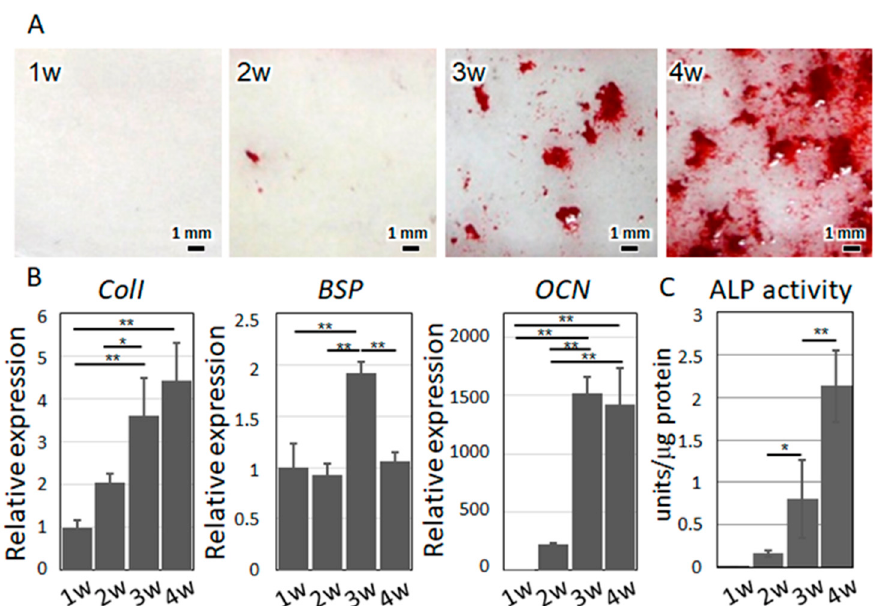
Figure 3. ( A ) Mineralized nodules were visualized by alizarin red S staining. ( B ) Gene expression analysis of osteoblast marker molecules. ColI , collagen I; BSP , bone sialoprotein; OCN , osteocalcin. ( C ) ALP activity depending on the cultivation period is shown. * p < 0.05, ** p < 0.01.